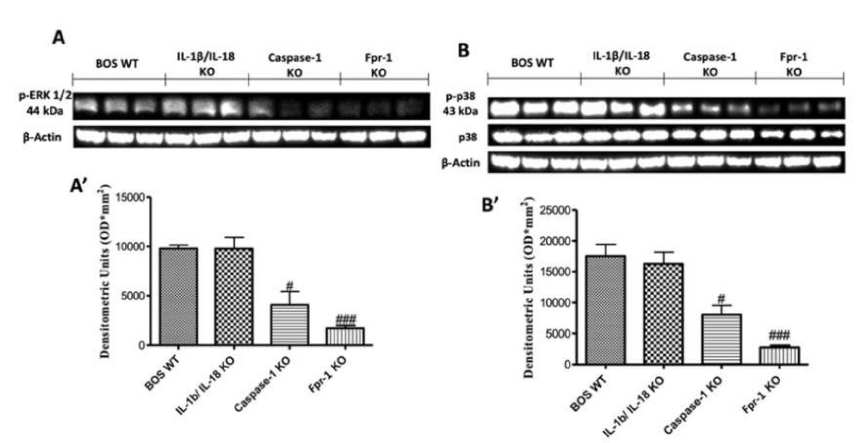
Figure 7. E ff ects of the absence of IL-1 β / IL-18, Casp-1, and Fpr-1 on the mitogen-activated protein kinase (MAPK) pathway. Western blots and, respectively, the densitometric analysis of p-ERK 1 / 2 ( A , A’ ) and p-p38 ( B , B’ ). For Western blot analyses, n = 5 animals from each group were employed. A p -value less than 0.05 was considered significant. # p < 0.05 versus the WT group, ### p < 0.001 versus the WT